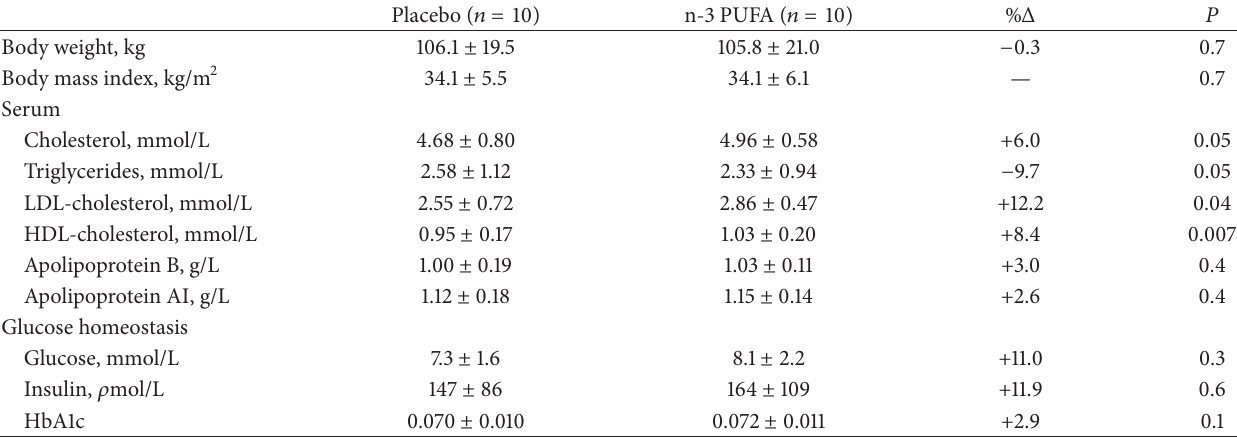
Table 1: Characteristics and fasting lipid/lipoprotein profile of the evaluated patients with type 2